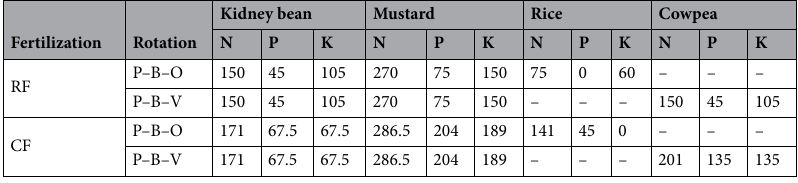
Table 1. Fertilization rate of each treatment in the long term crop rotation experiment (kg/hm 2 ). N fertilizer is urea, P is calcium superphosphate, K is KCl; the fertilization amount in the table was calculated from the chemical content of the